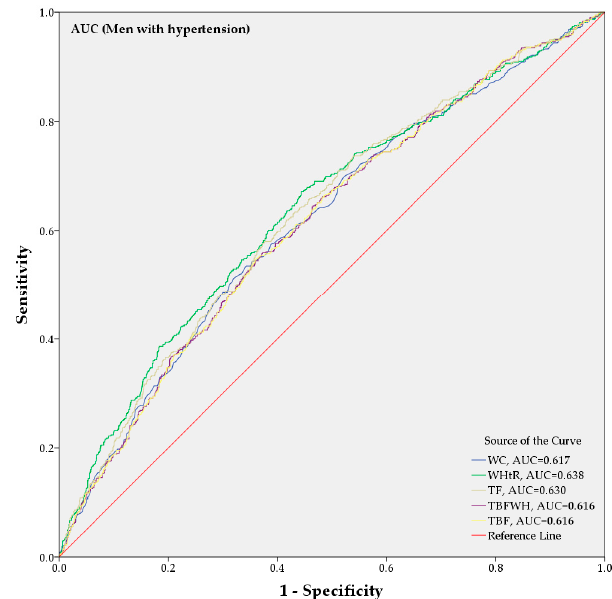
Figure 3. Area under the curve (AUC) analysis of hypertension based on anthropometrics and body composition in men.